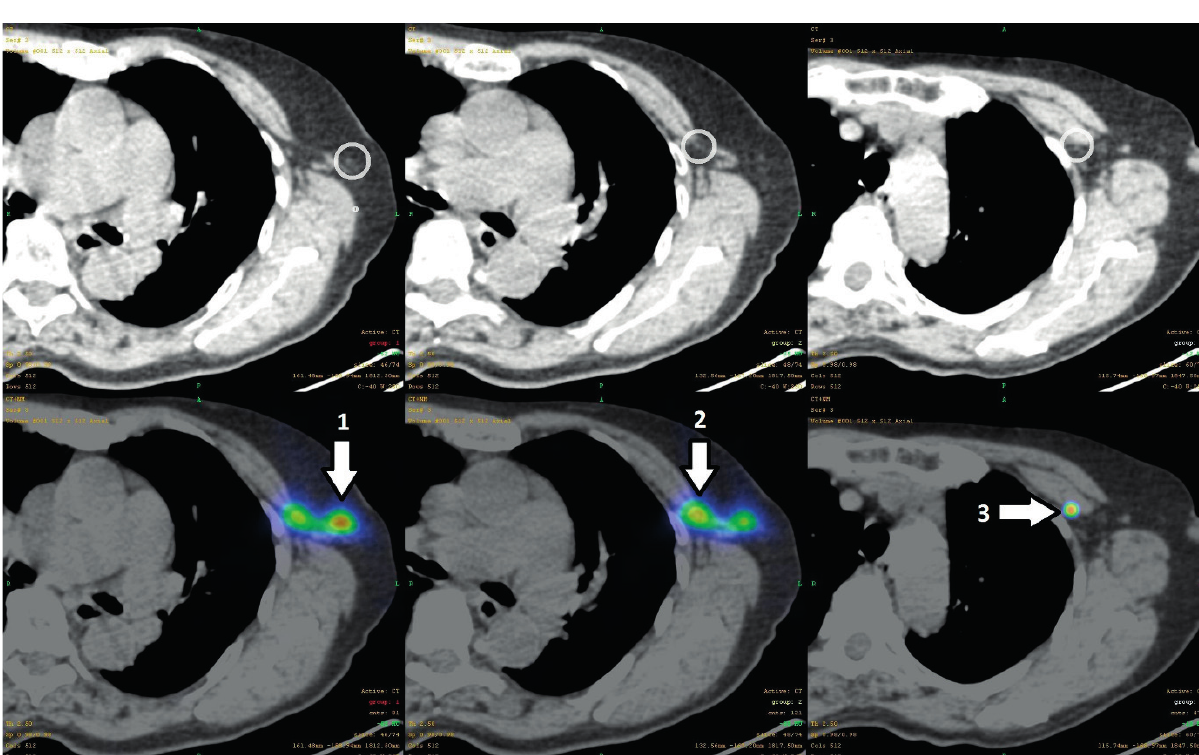
Fig. 4. Imaging of lymph node chain in the direction of lymph flow right to left – from the surface (1) up to deeply subpectorally localized lymph nodes (3).(CT images top, fused SPECT/CT images